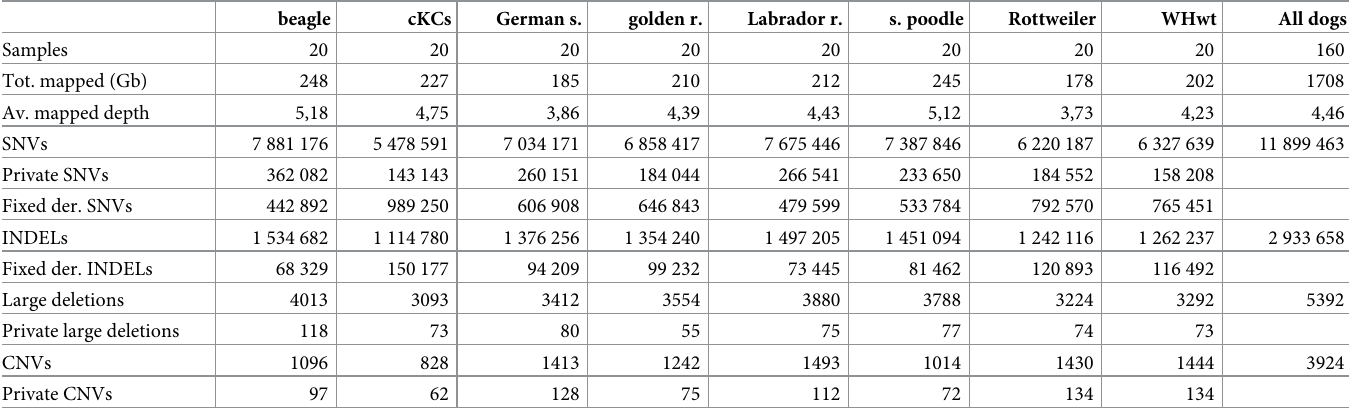
Table 1. Summary of sequencing and variant discovery.